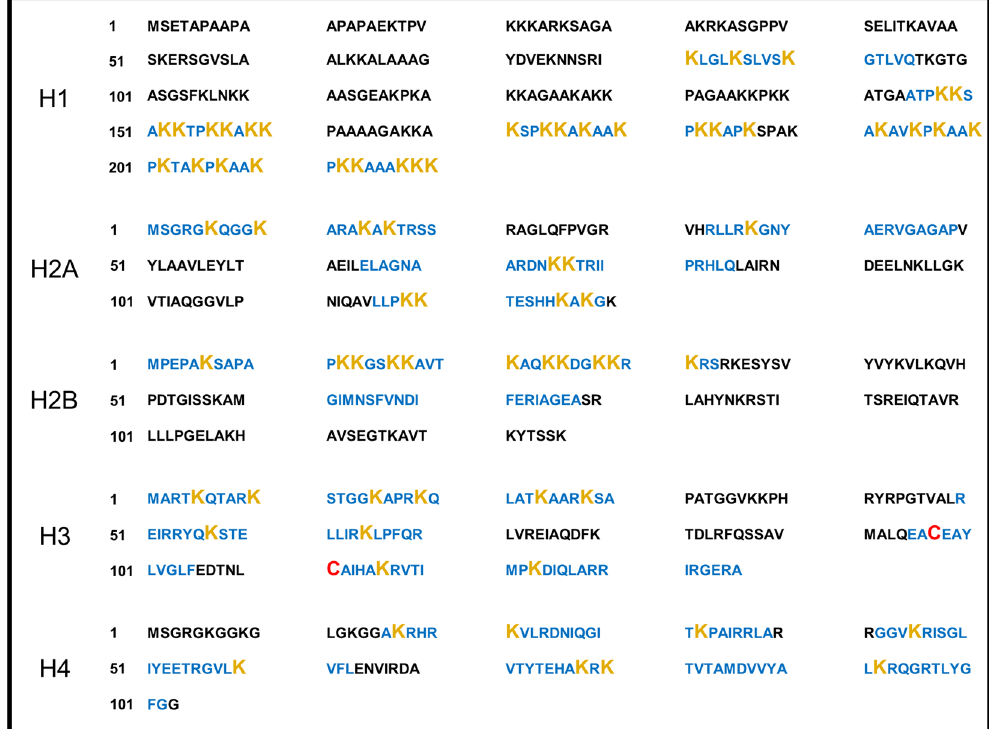
Figure 1. Protein sequences of histones. Protein sequences of histone regions which are exposed at the surface ( blue ). Lysine bearing free amine group ( orange ); Cysteine ( Red